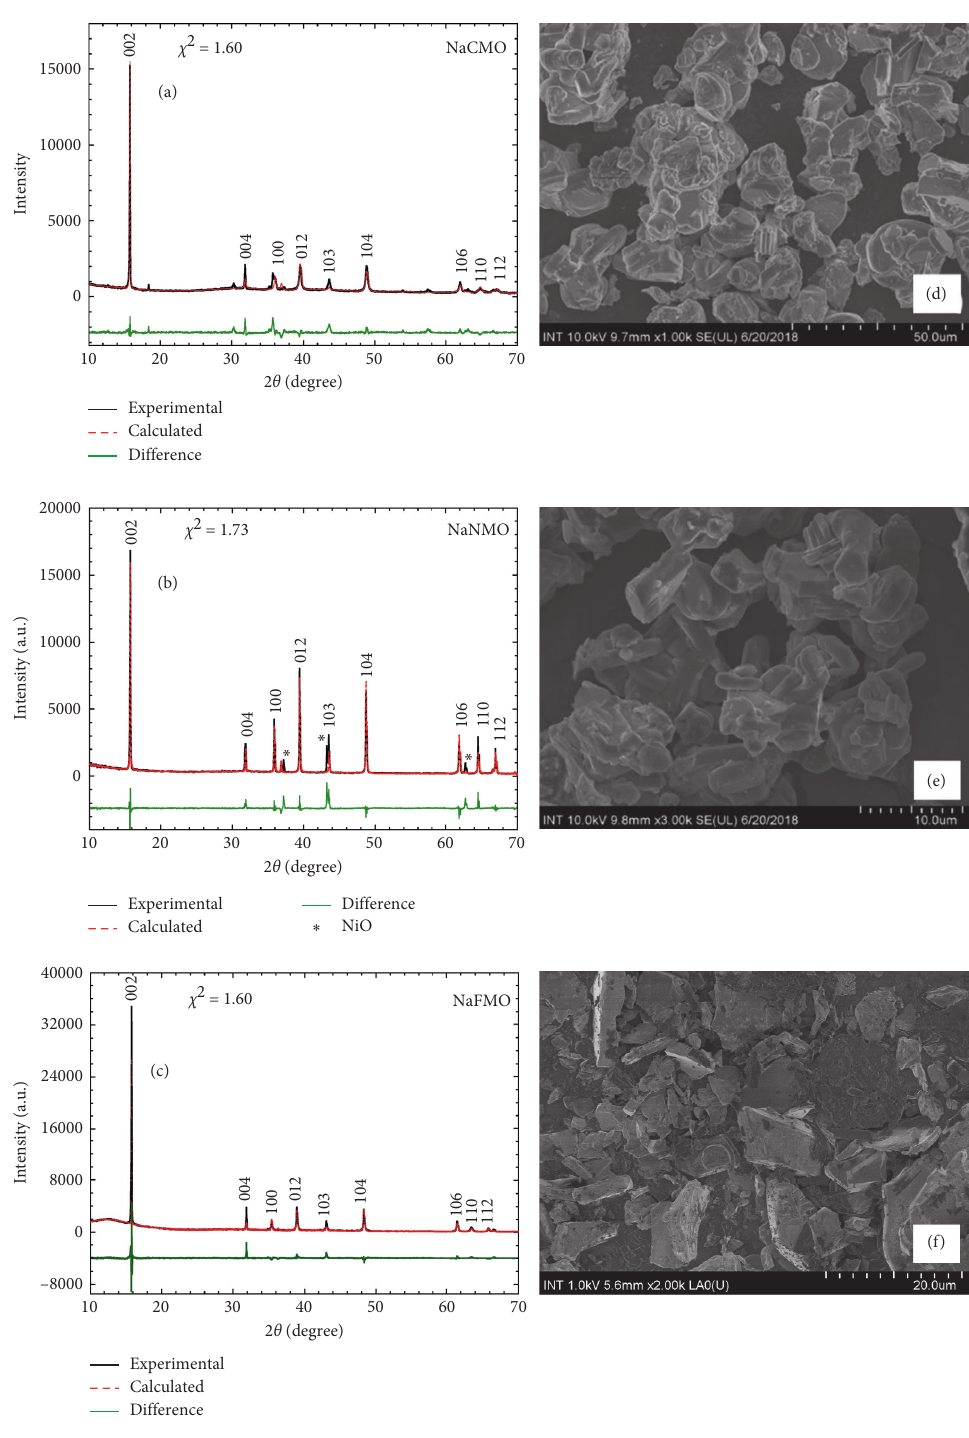
Figure 1: Rietveld refinement results for the as-prepared NaCMO sample (a), NaNMO sample (b), and NaFMO sample (c). SEM images of NaCMO sample (d), NaNMO sample (e), and NaFMO sample (f). Table 1: Lattice parameters of the samples calculated from Rietveld